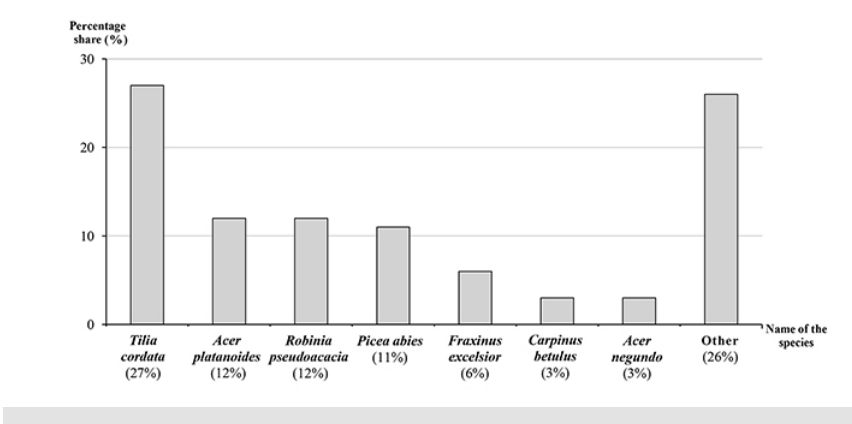
Fig. 4 Percentage share of tree species in Felin Manor Park (in